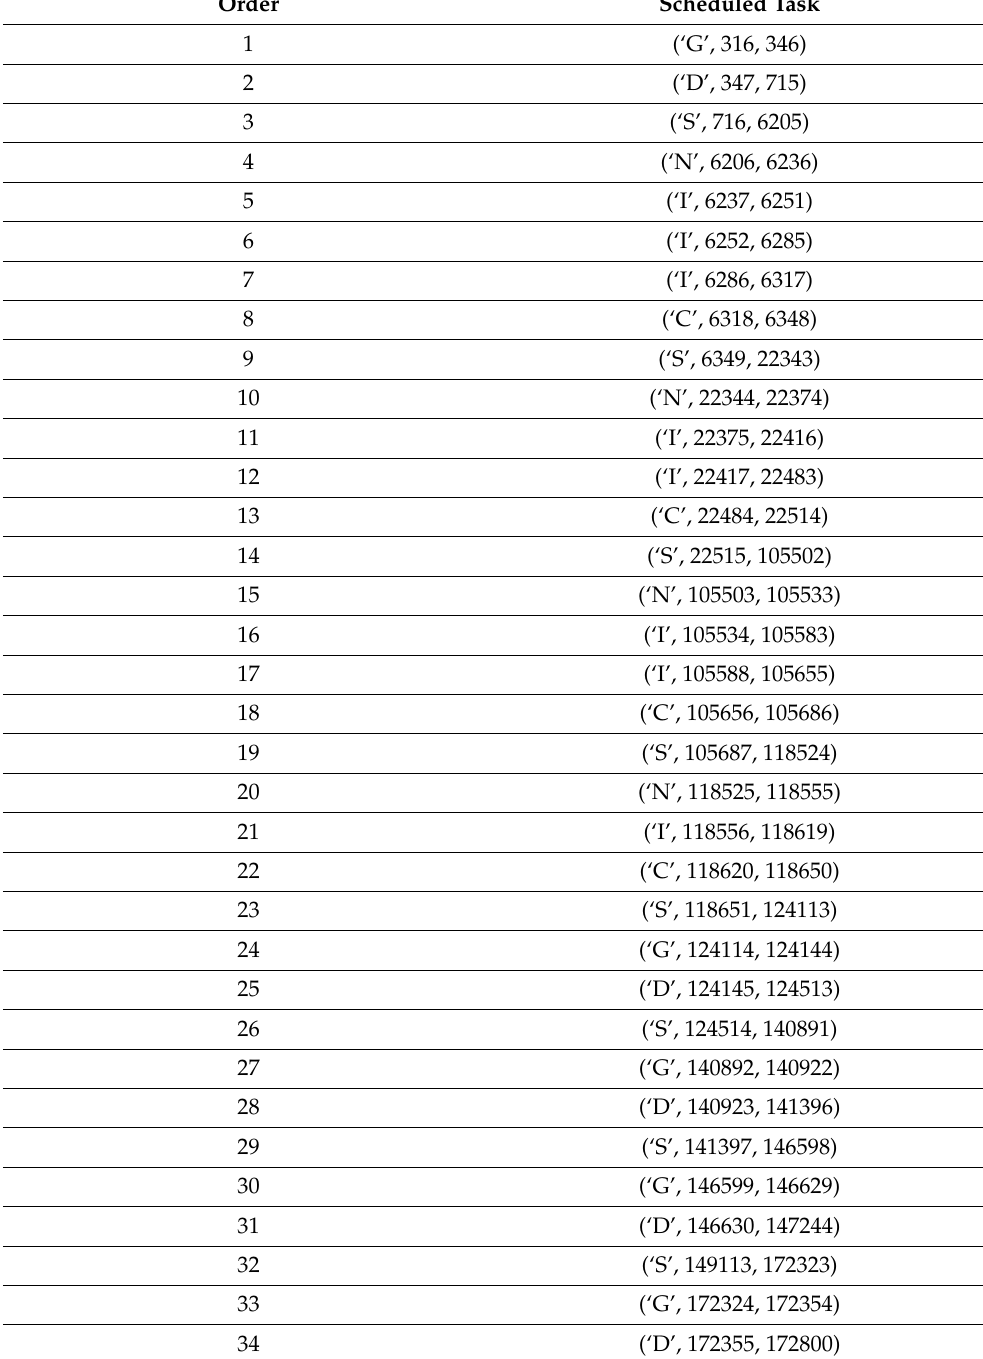
Table 6. RL-Based Scheduling